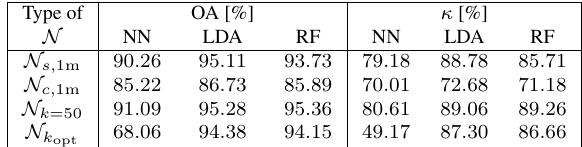
Table 2. Classification results obtained for Oakland-5C when us- ing the original point cloud, four different neighborhood types and three different